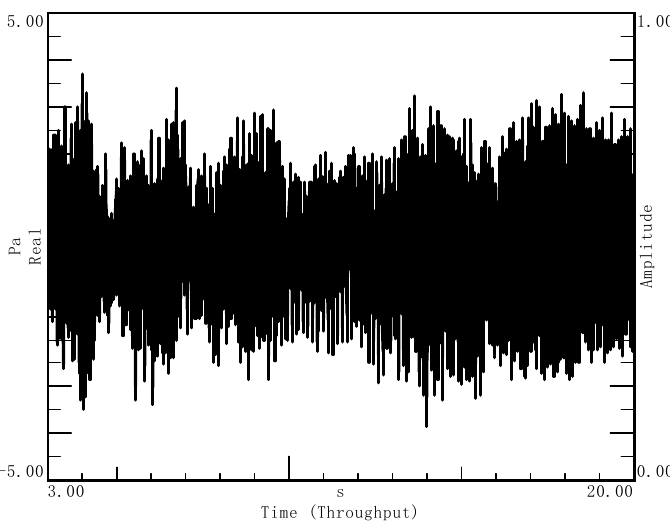
Figure 6. In-vehicle sound signal for acceleration conditions.